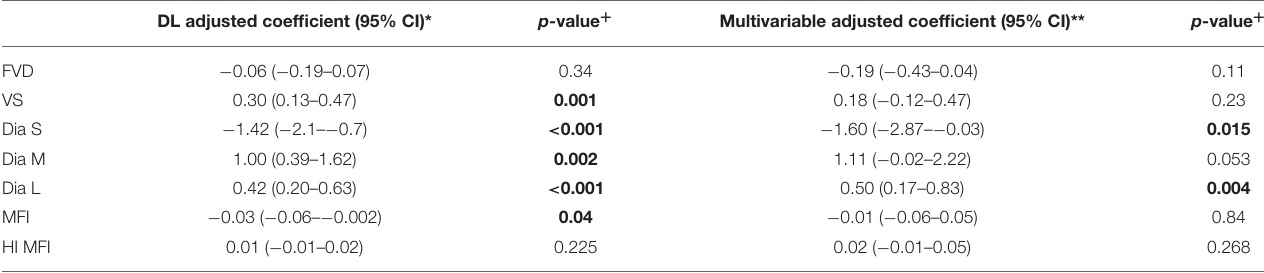
TABLE 3 | Linear regression models of the association between gestational age (GA) at birth and microcirculatory parameters. DL adjusted coefficient (95% CI)*